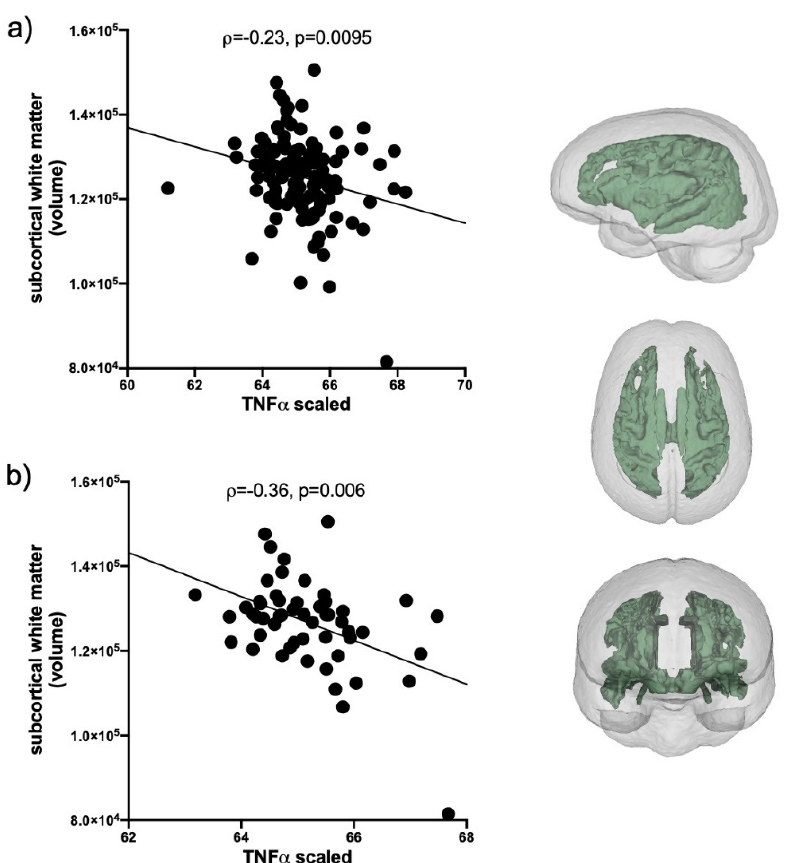
Figure 3. TNF α correlations with subcortical white matter volume. ( a ) In HCV seropositive AUD individuals and the 2 HIV groups (black circles, n = 127). ( b ) In the subset of HCV seropositive individuals collapsed across the 3 patient groups (black circles, n = 57). Inset: subcortical white matter volume.